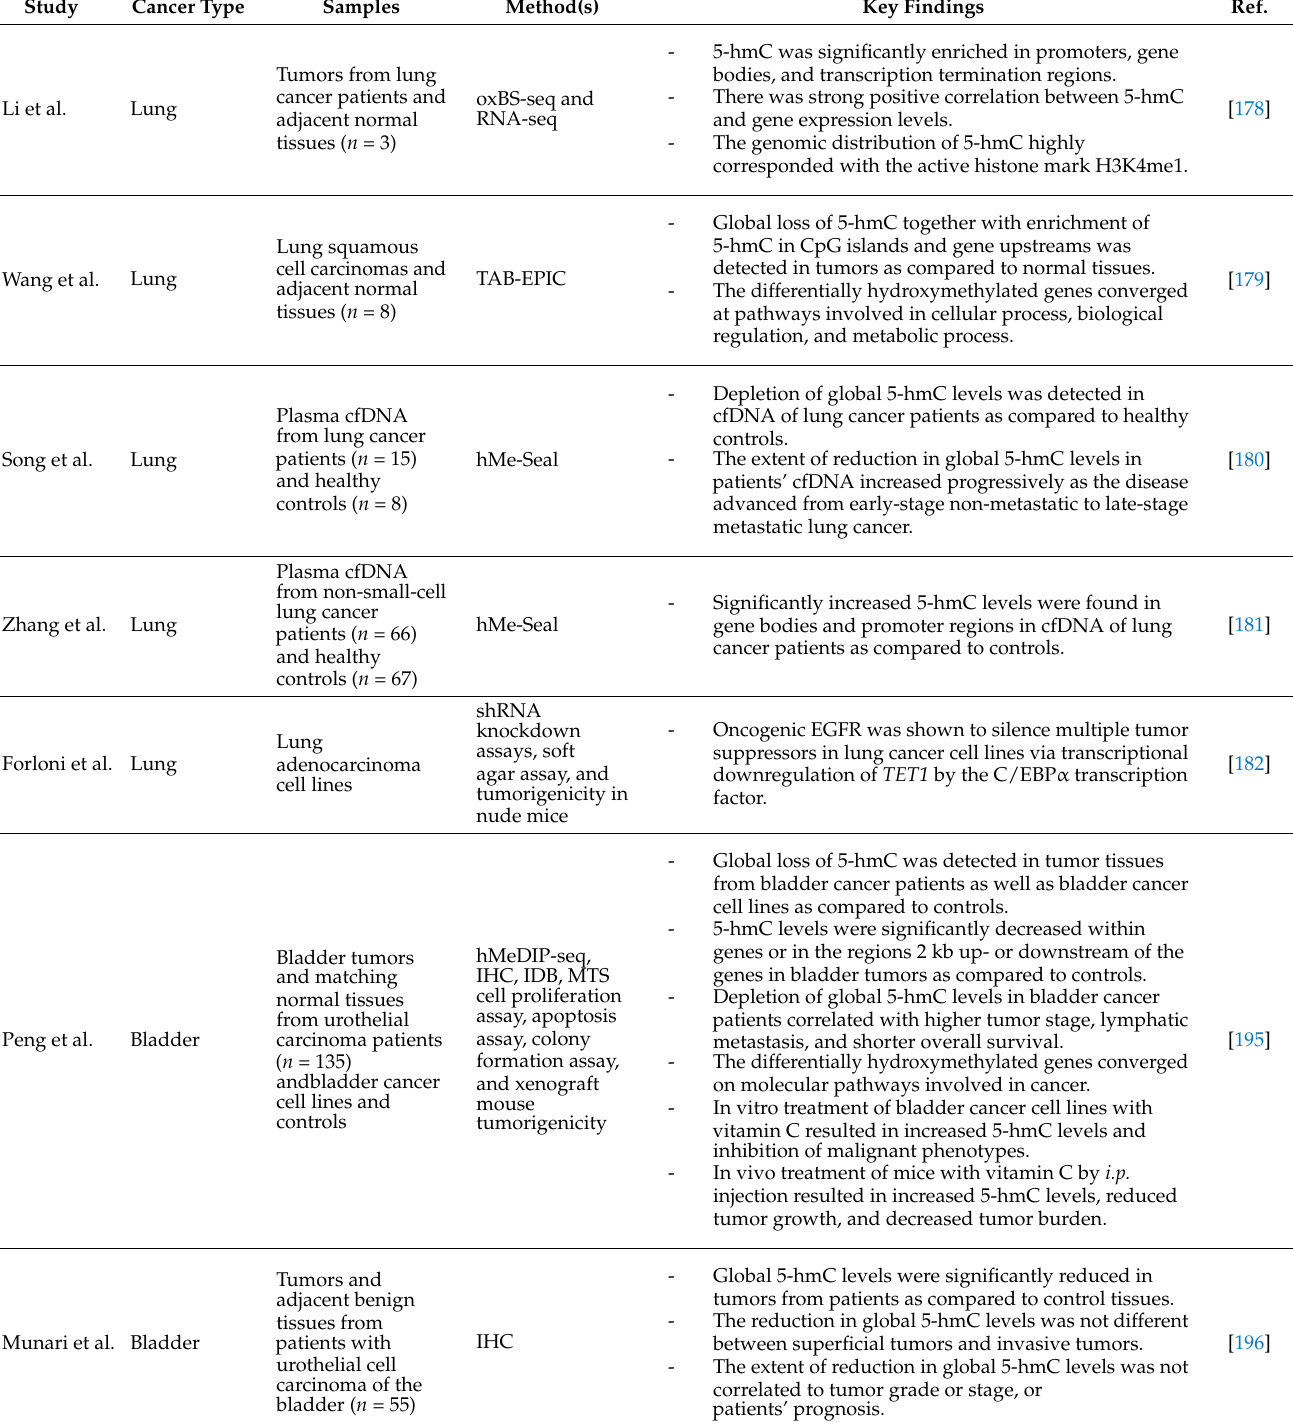
Table 1. Summary results of selected studies on DNA hydroxymethylation and three major smoking- associated cancers (i.e., lung, bladder, and colorectal